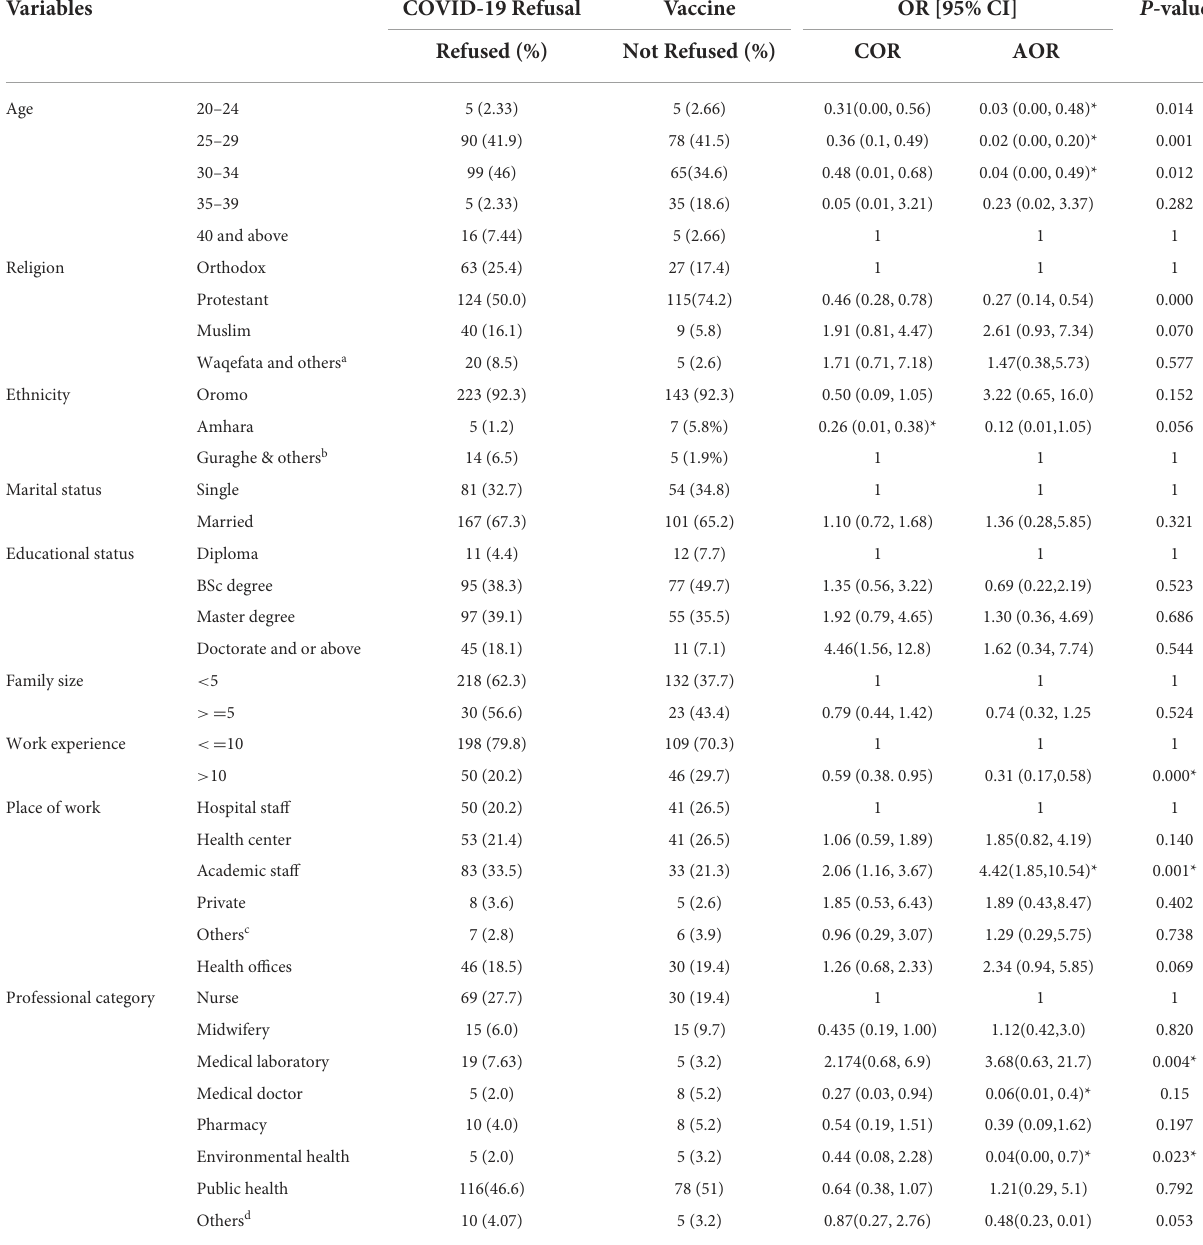
TABLE 2 Socio-demographic factor associated with COVID-19 vaccine refusal among